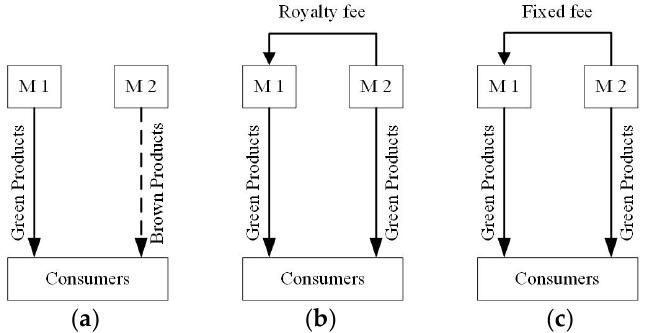
Figure 1. Supply chain structures. ( a ) Strategy N; ( b ) Strategy R; ( c ) Strategy F.